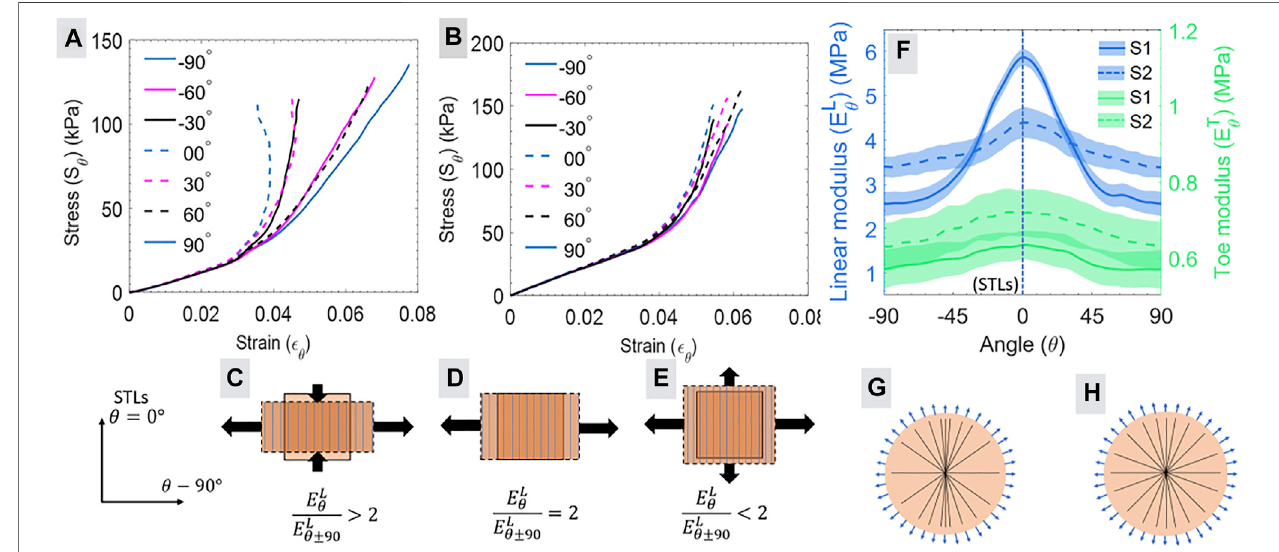
FIGURE 6 | (A, B) illustrates the stress-strain calculated at an interval of 1 ° for the subjects S1 and S2, respectively, with a reduced number of angles. The wide- span width of (A) shows more anisotropy than the narrow span width in (B) . The modulus ratio calculated for the linear regions based on (A, B) can be characterized in three categories shown in (C – E) . The vertical lines represent the direction of collagen fi bers, and an arrow represents the strain. ( − 90 ° and 90 ° represents the same direction). (F) shows themeanand standarddeviation forthevariationinthe linearmodulus (left y -axis)and toe modulus (right y -axis) withtheangle forsubjectsS1 and S2. The schematic in (G) and (H) illustrates the probability of directional distribution intensity of collagen fi ber (straight lines) distribution for subjects S1 and S2, respectively. The higher modulus variation (in A) for S1 shows more preferential orientations of fi bers as represented in (G) , and the lower variation (in B) shows a more uniform distribution of fi bers described in (H)